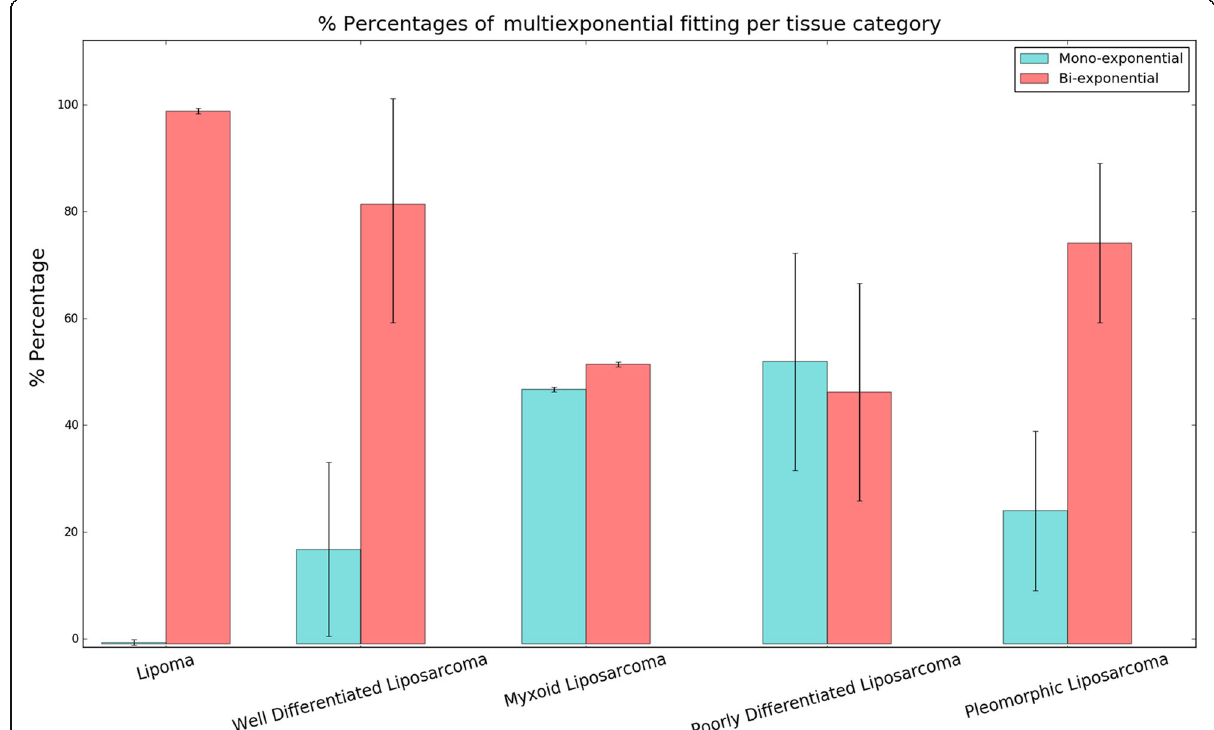
Fig. 3 Relative contribution of monoexponential and biexponential behaviour for each tumour